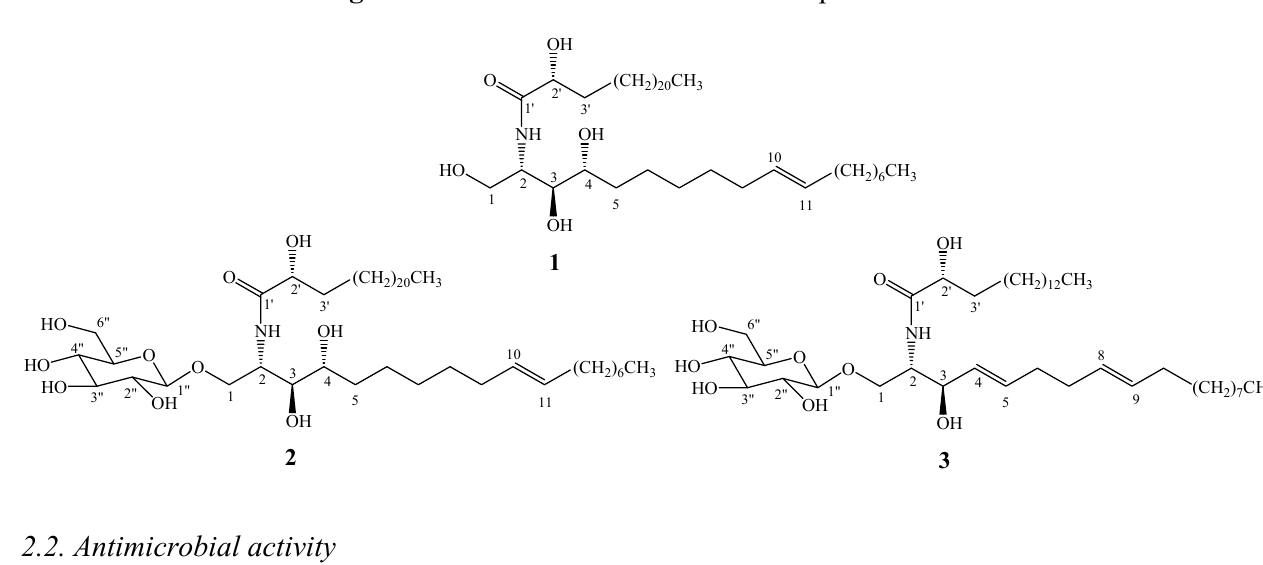
Figure 1. Chemical structures of the compounds 1 - 3